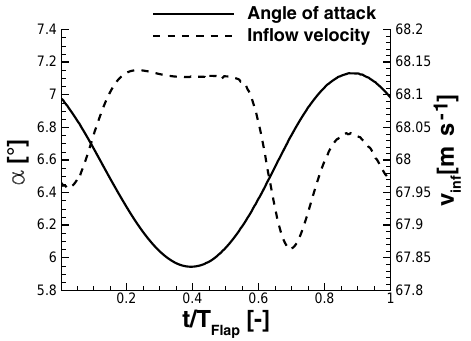
Figure 17. 1p instantaneous inflow conditions 3-D, 75% radius.